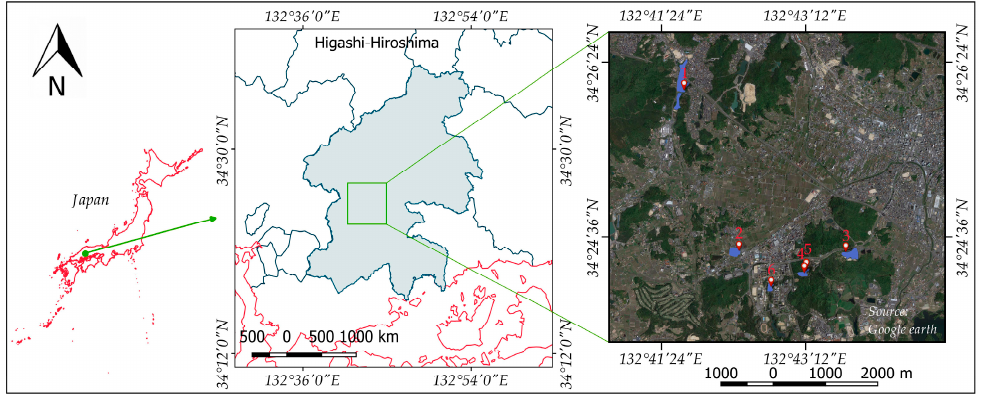
Figure 1. Locations of Higashihiroshima and the six irrigation ponds used in this study. Table 1. The six irrigation ponds in the study.